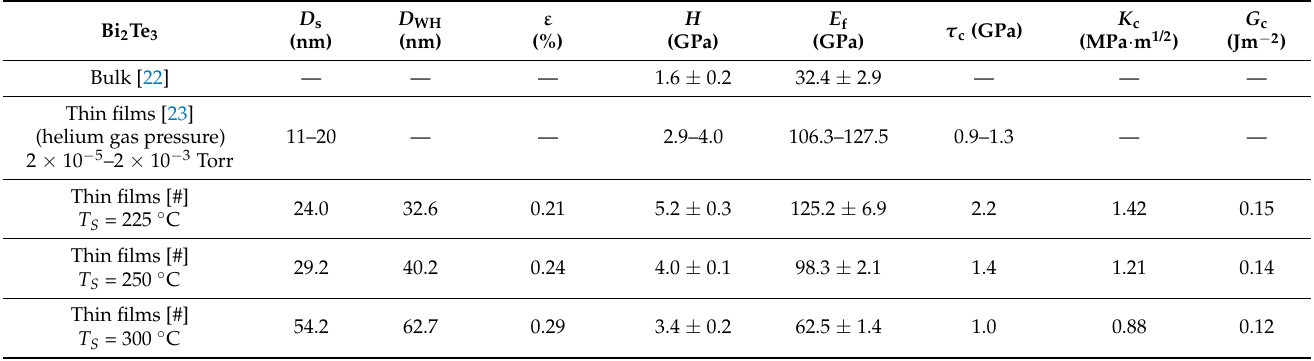
Table 1. The structural and mechanical properties of the Bi 2 Te 3 thin